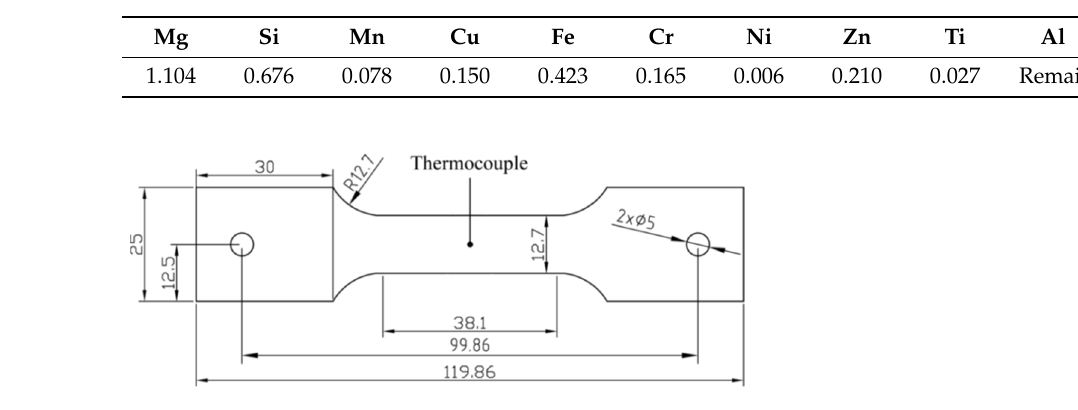
Figure 4. Dimensions of the samples for conduction heating.